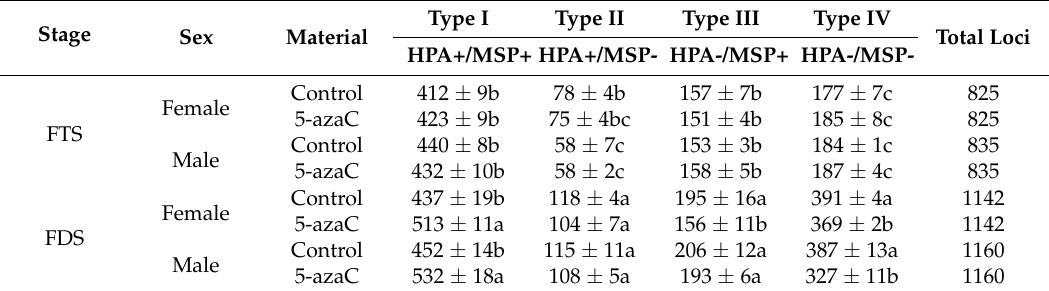
Table 2. Number of DNA methylated loci identified using MSAP.